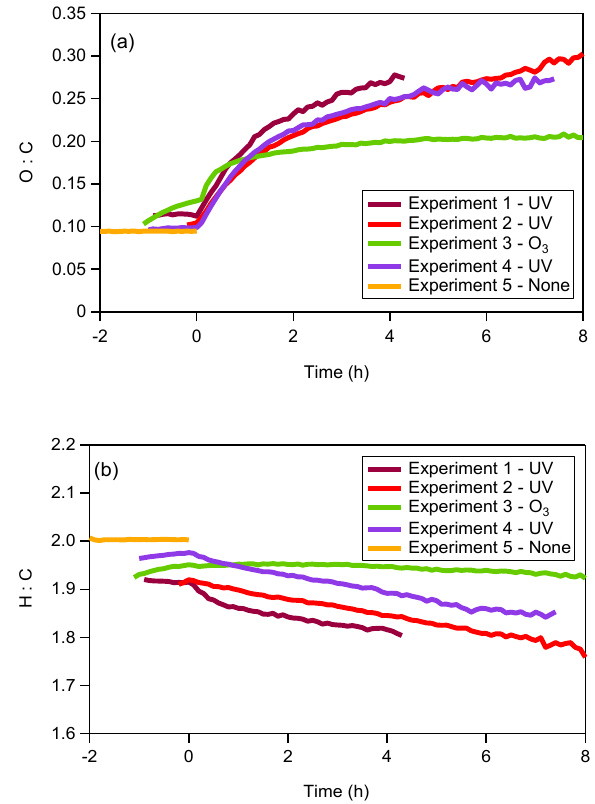
Figure 3. (a) O : C ratios and (b) H : C ratios for the COA smog chamber experiments. Time zero corresponds to the beginning of the aging process.